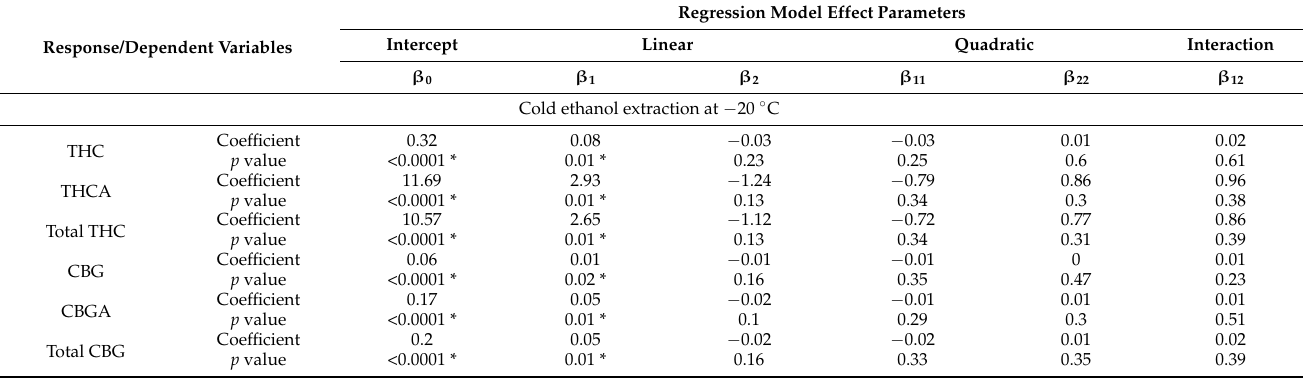
Table 2. Regression equation coefficients for cold ethanol extraction of cannabis with different experimental